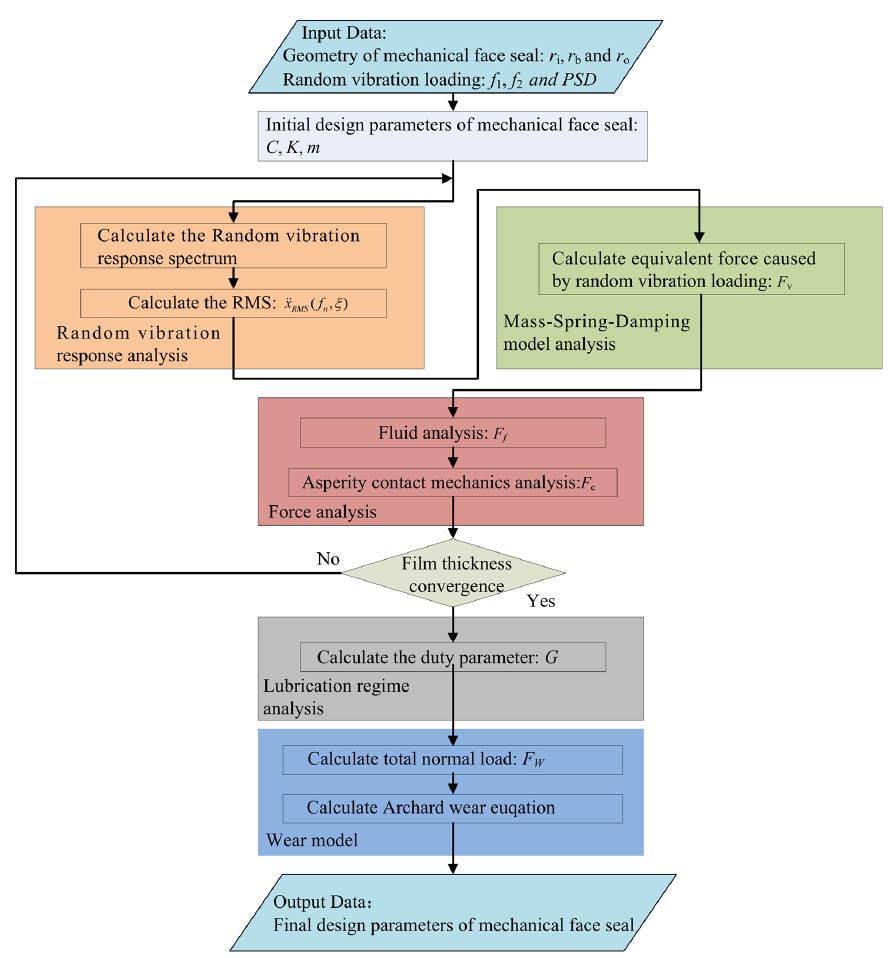
Figure 3. Flowchart of the proposed simulation method.